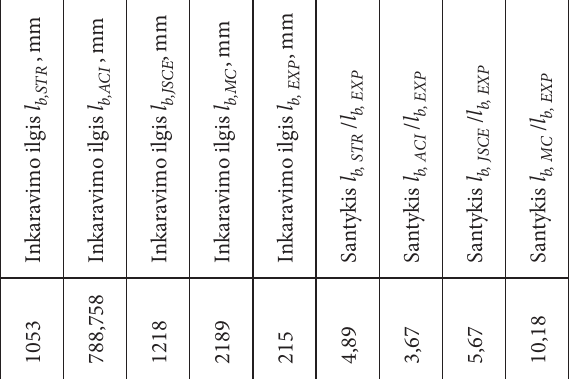
Fig. 4. Experimental and theoretical by STR, ACI, JSCE, MC codes anchorage length of carbon fi ber reinforced polymer (CFRP)